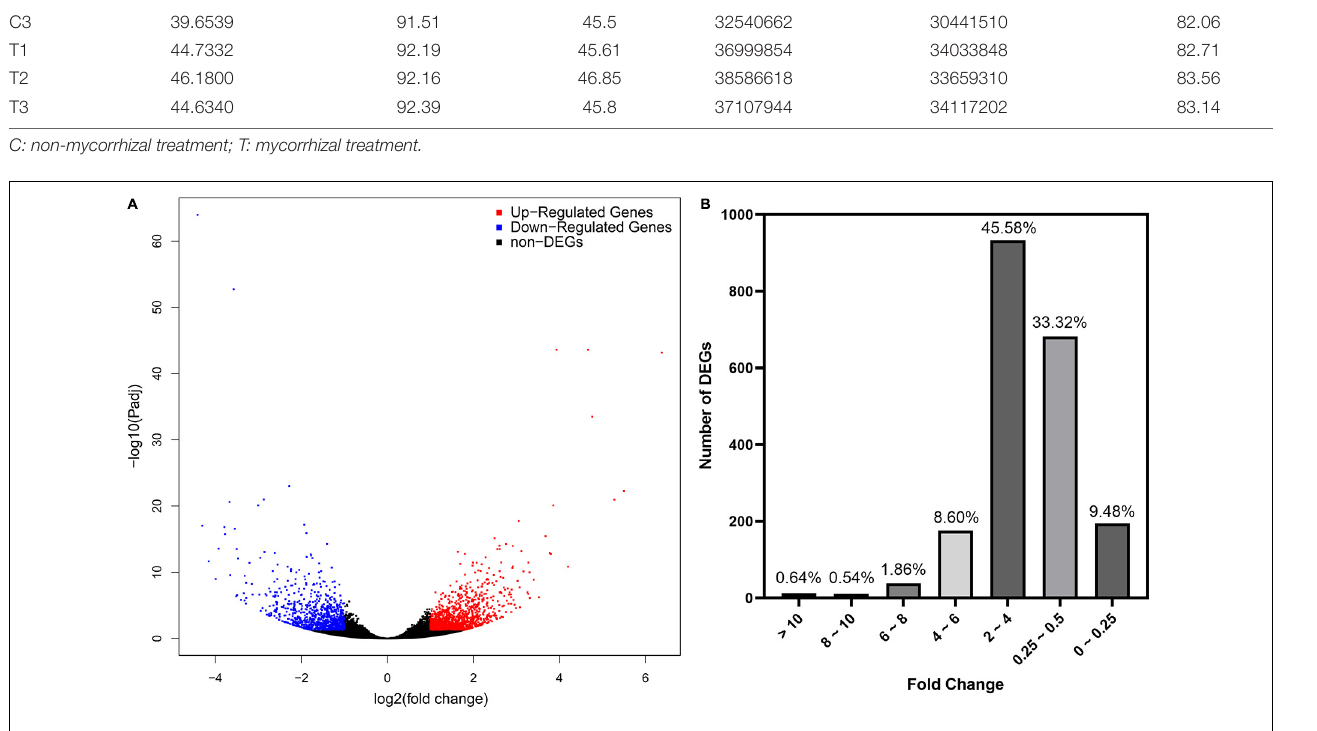
FIGURE 3 | Preliminary statistics of differentially expressed genes (DEGs) between mycorrhizal and non-mycorrhizal treatment. (A) : Differentially expressed genes in volcano plot. Blue and red dots indicate the significantly downregulated and upregulated genes, respectively. (B) : Number of DEGs grouped by fold change. “Fold Change” indicates the ratio of expressions in T and C treatment of the same